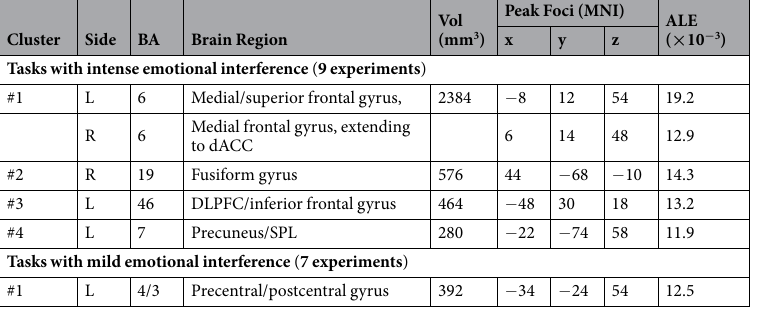
Cluster Side BA